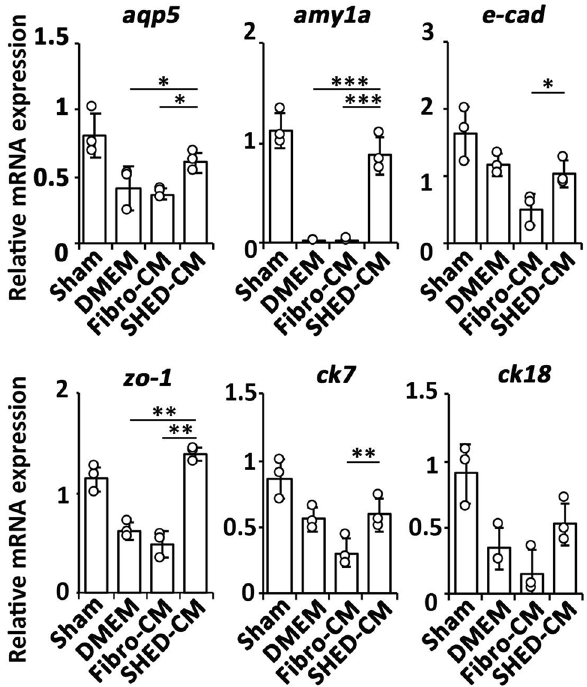
Figure 3. SHED-CM preserves functional and structural markers expression after mouse SG irradiation. Quanitative real-time polymerase chain reaction analysis of the indicated mRNAs in the SG 24 h after the last CM treatment. The results are expressed relative to the level in the sham group. Comparisons between groups were analyzed using an ANOVA with Tukey’s multiple comparisons test (n = 3). Data are represented as